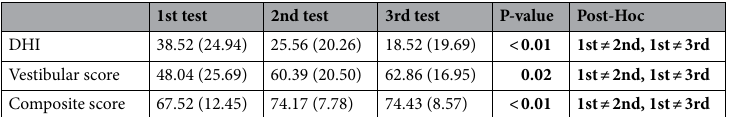
Table 3. Changes in clinical measurements during repeated tests in uVN. 1st test were conducted within 2 weeks of Department of Otorhinolaryngology-Head and Neck Surgery. 2nd test and 3rd test were conducted after 4 weeks and 8 weeks of 1st test. P-values are from the statistical test for the time effect on variables. Values are presented as mean (SD). uVN unilateral vestibular neuritis, DHI Dizziness Handicap Inventory.